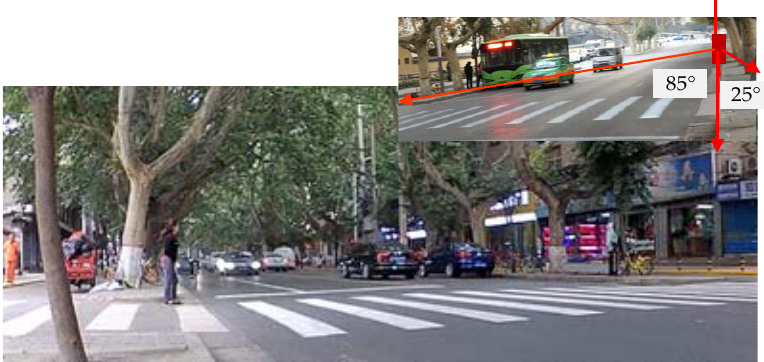
Figure 3. Photographs of the experimental section.